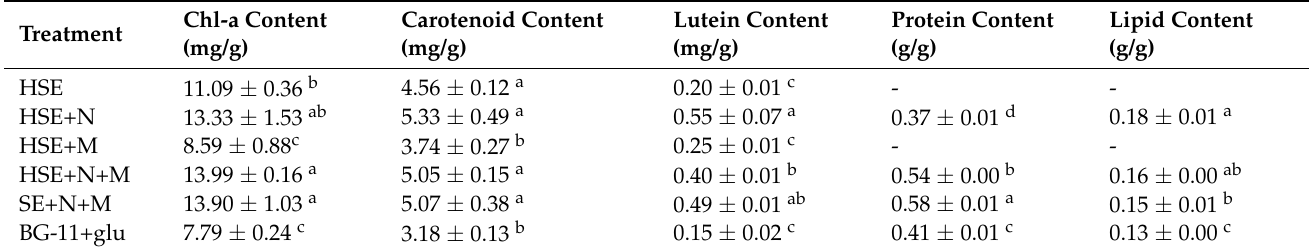
Figure 3. The productions of chlorophyll-a ( a ), carotenoid ( b ), lutein ( c ), protein, and lipid ( d ) of the harvested heterotrophic C. vulgaris . Different superscripts ( a – d ) indicate significant differences ( p < 0.05). Table 4. Nutrients and pigments contents of heterotrophic C. vulgaris .